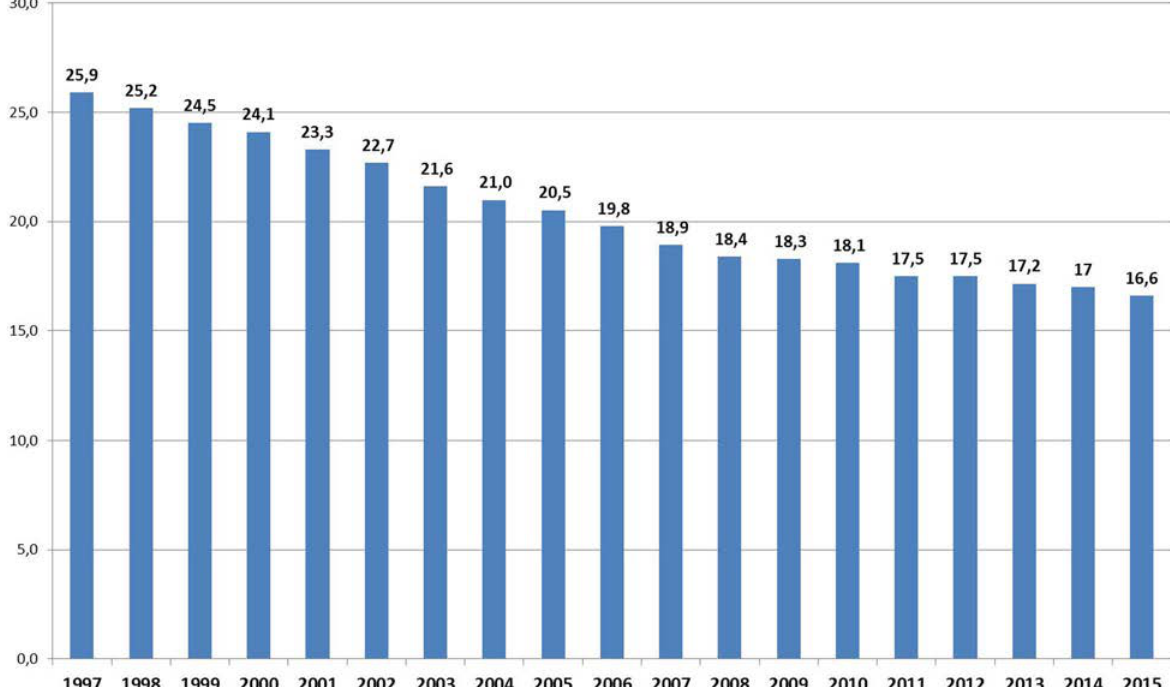
Fig. 4. Number of dairy cows in North Karelia, 1997–2015. Source: Pro Agria